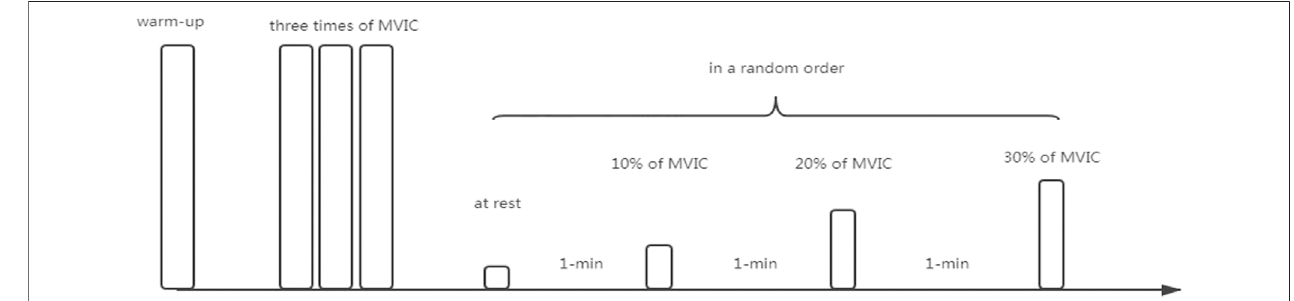
FIGURE 1 | Experimental design. The fi rst is a warm-up to prepare for MVICs, followed by 3 times of MVIC, and the average of the three MVICs is used for subsequentresistancesettings,andthekneejointisometricresistancestretchingtasks(0,10,20%,and30%MVIC)areperformedinrandomorder.Eachtasklasts5 s, with 1 min intervals between tasks.